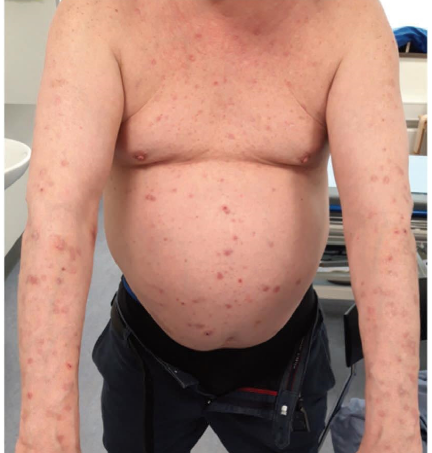
Figure 1: Picture of the patient’s skin lesions before occlusive